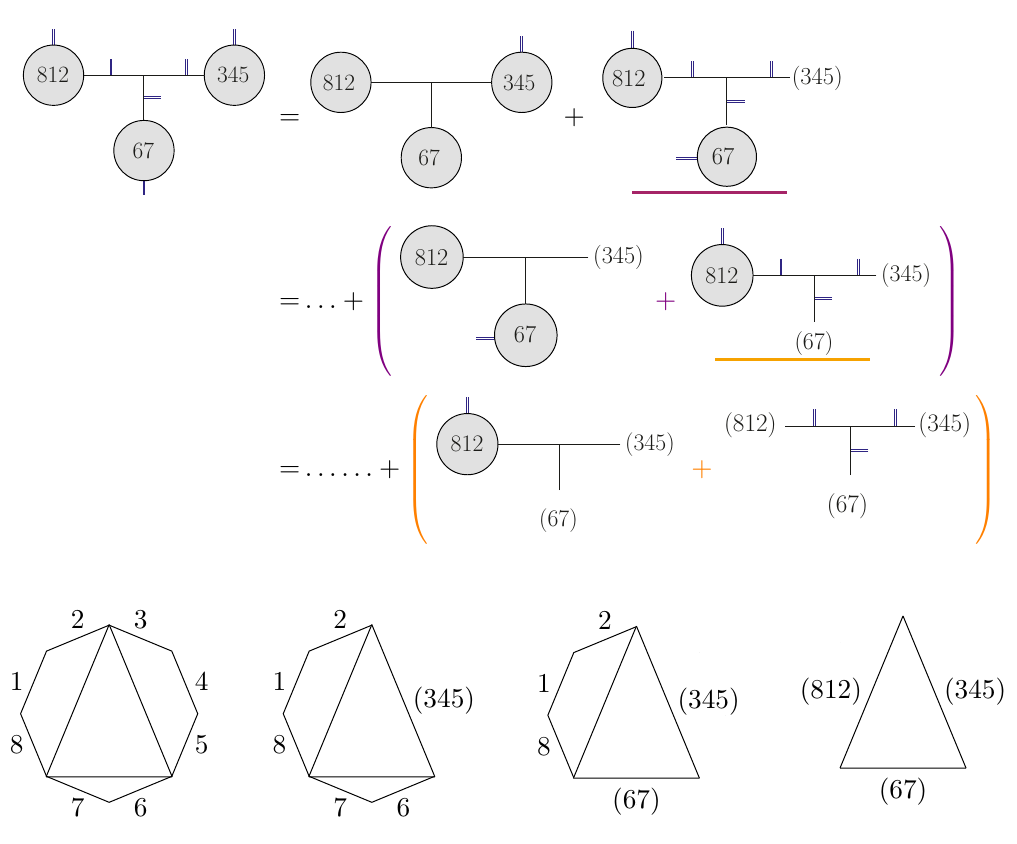
Figure 4. Feynman diagrams computed in each steps of the expansion for 2 ) (8 , 1 , 2 , 6 , 7 , 3 , 4 , 5 | 1 , 2 , 3 , 4 , 5 , 6 , 7 , 8) (top), and the reduction of the mutual partial tri- F tr( φ 8 angulation(bottom). Note that the purple underlined term in the first row becomes the two terms in the purple parenthesis in the second row; and the orange underlined terms in the second row becomes the two terms in the orange parenthesis in the third